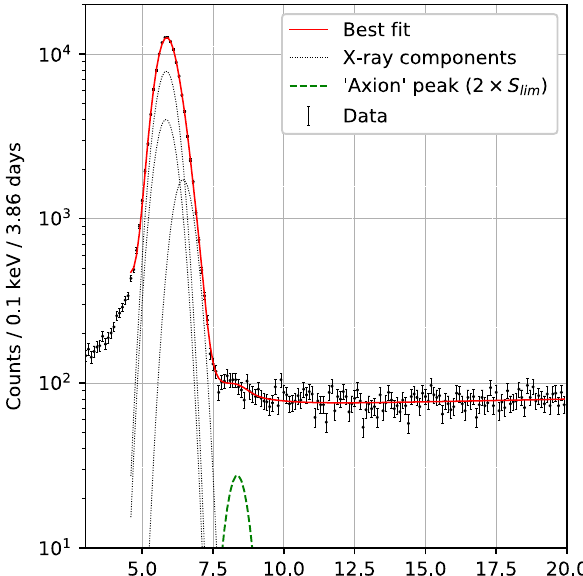
Fig. 3 Spectrum of events obtained during the live time of 3 . 9 days by Tm 3 Al 5 O 12 bolometer in 3 − 20 keV energy interval with 0 . 1 keV binning. The result of fitting by model (14) is presented by solid line. The presumed “axion” peak with area S = 2 × S lim is shown by the dashed line (the area is increased to improve